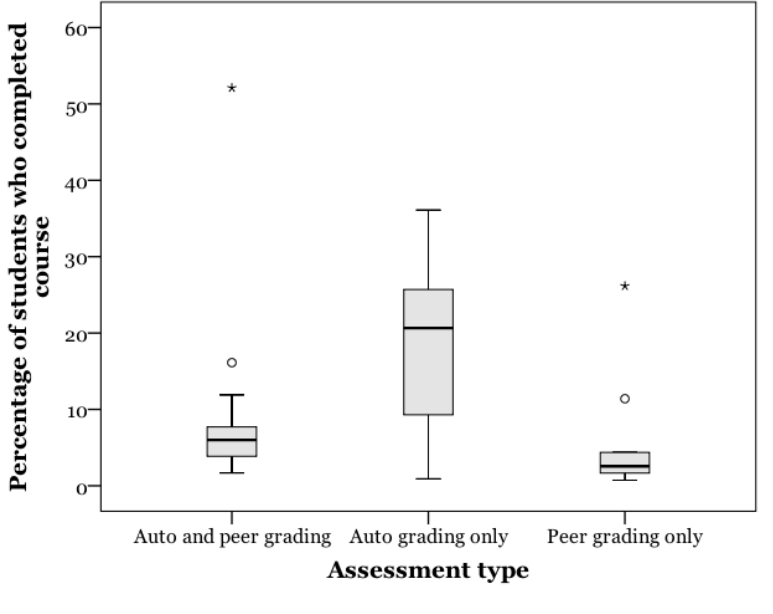
Figure 4. Boxplots showing distributions of completion rates according to different assessment